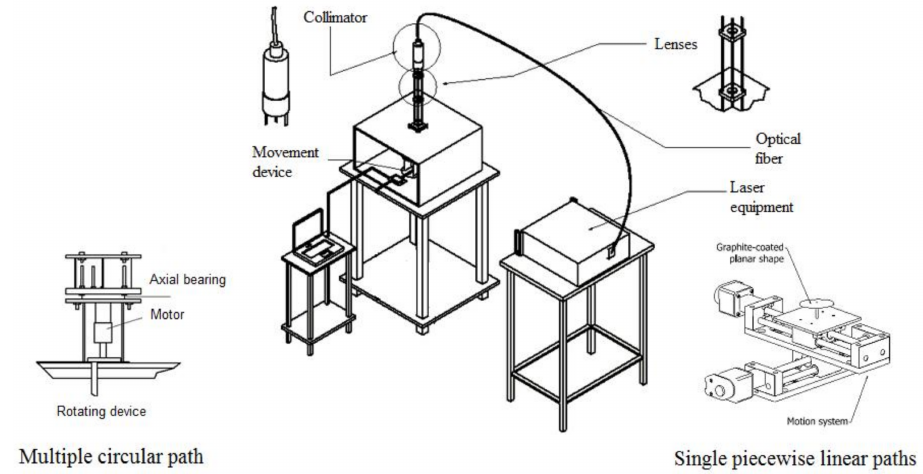
Figure 4. Multiple circular and single piecewise linear scanning paths: experimental